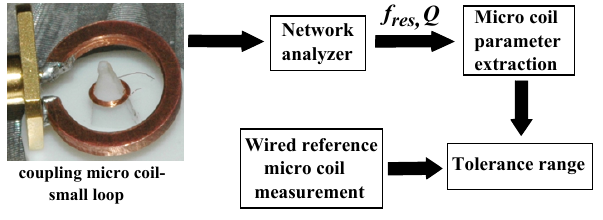
Figure 8. Wireless measurement approach overview.